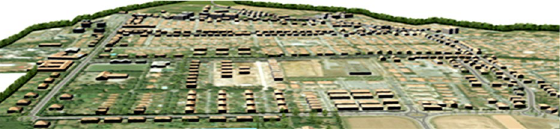
Fig. 6. Virtual reproduction of the urban path (top view)